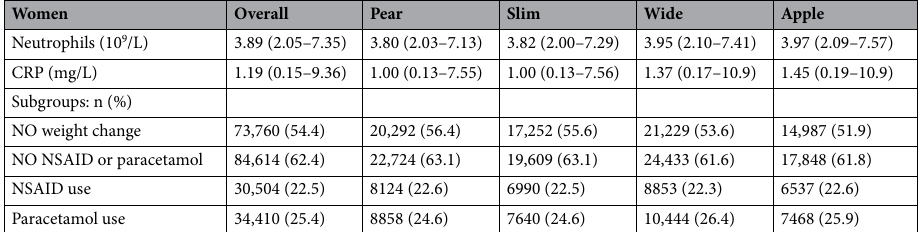
Table 1. Anthropometric characteristics of study participants and biomarker levels. ABSI – a body shape index (cut-offs ≥ 80 for men, ≥ 73 for women); ALP – alkaline phosphatase; ALT – alanine aminotransferase; Apple – large-ABSI-small-HI; AST – aspartate aminotransferase; BMI – body mass index; CRP – C-reactive protein; GGT – gamma-glutamyltransferase; HbA1c – haemoglobin A1c (glycated haemoglobin); HDL-C – high-density lipoprotein cholesterol; HI – hip index (cut-offs ≥ 49 for men, ≥ 64 for women); LDL-C – low- density lipoprotein cholesterol; NSAID – nonsteroidal anti-inflammatory drugs; Pear – small-ABSI-large-HI; Slim – small-ABSI-small-HI; Wide – large-ABSI-large-HI; a – mean (standard deviation); b – geometric mean (reference